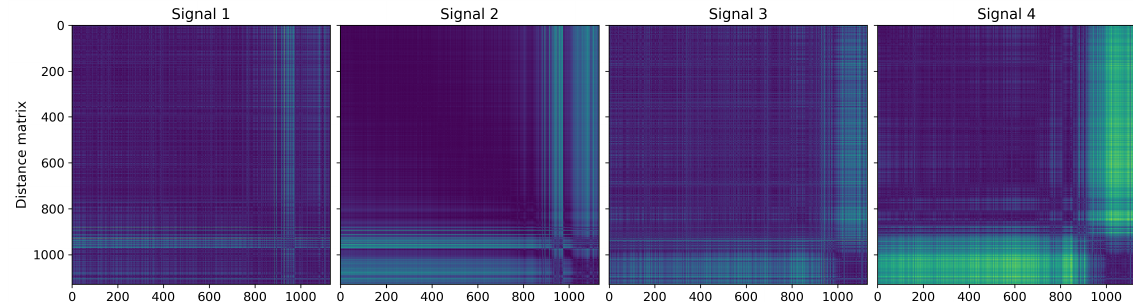
Figure 7. Distance matrices {G 1 , G 2 , G 3 , G 4 } extracted from { X 1 , X 2 , X 3 , X 4 } .